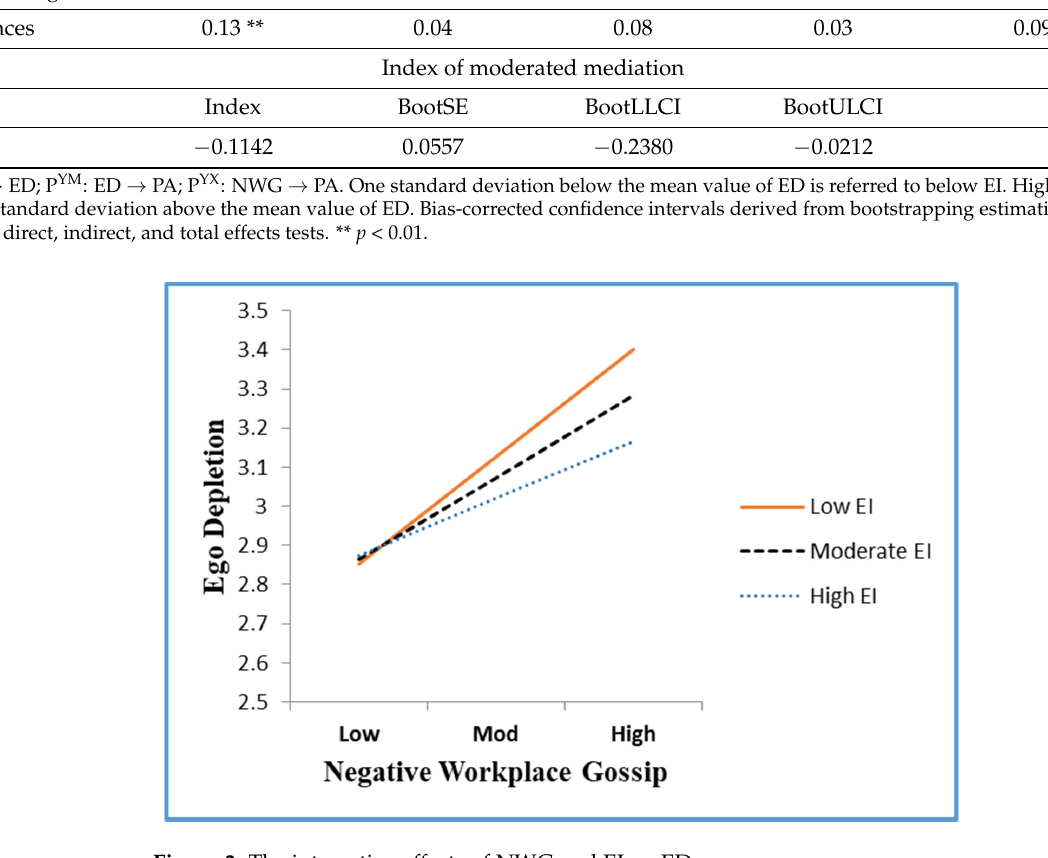
Figure 3. The interactive effects of NWG and EI on ED.